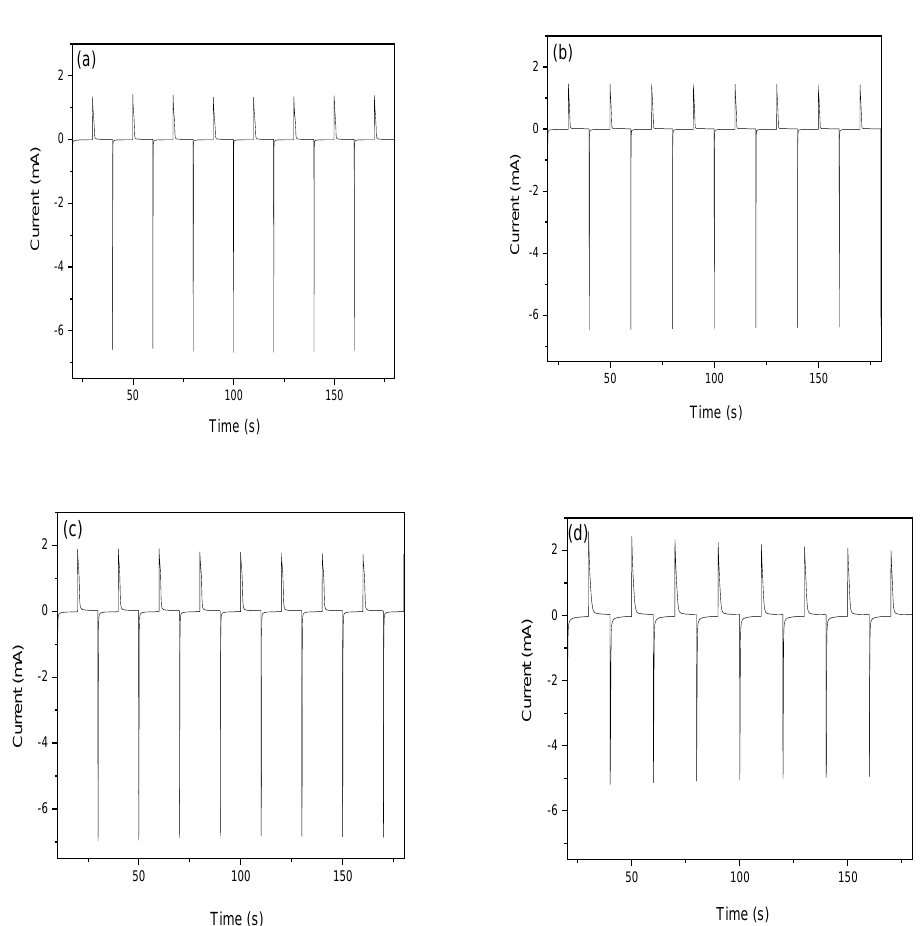
Figure 6. Chronoamperometry of ( a ) Fe-Tt ( b ) Fe-TtE ( c ) Fe-TtPh and ( d ) Fe-TtB films with a 10 s delay between 0 V and 1.4 V. The optical contrast ( ∆ T ) measured at corresponding wavelengths (Table 3) was found to be 29.0% for Fe-TtB and increased to 64.5% for Fe-Tt . For comparison, Zhu et al. reported for electrochromic conjugated polymers based on thieno[3,2- b ]thiophene the